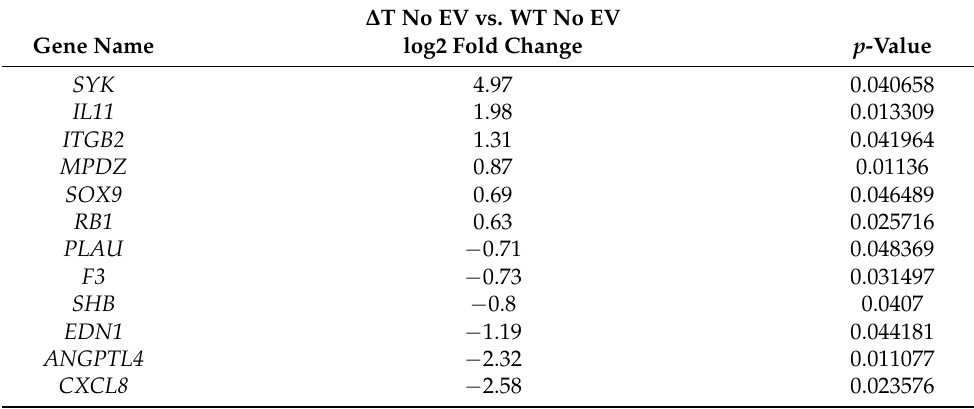
Figure 4. Endogenous Twist1 influences the functional and molecular phenotype of PC3MLs. PC3MLs expressing either wild-type levels of TWIST1 (WT), deficient ( Δ T), or overexpressed (T oe ) TWIST1 were incubated with BrdU for 6hrs, and BrdU incorporation was scored via fluorescence microscopy. Proliferation was correlated with TWIST1 expression; PC3MLs deficient in TWIST1 had significantly lower proliferation than wild-type ( n = 5), and PC3MLs overexpressing TWIST1 had significantly increased proliferation ( n = 5) ( A ). Invasion was assessed using Matrigel invasion chambers; overexpression of TWIST1 significantly increased invasion in PC3MLs as compared to wild-type and cells deficient in TWIST1 ( n = 5) ( B ). Volcano plots show DE genes with an x-axis indicating DE fold change with a threshold of +/ − 0.58 log2 fold change, p < 0.05. Differential expression (DE) analysis revealed 12 DE genes in ∆ T vs. WT and 29 DE genes in T oe vs. WT ( C ). IPA analysis revealed genes deregulated in ∆ T or T oe vs. WT PC3MLs whose regulation status may impact on observed changes in proliferation ( D ) or invasion ( E ). Genes in blue are downregulated, and genes in orange are upregulated. Table 5. Differentially expressed genes in ∆ T versus